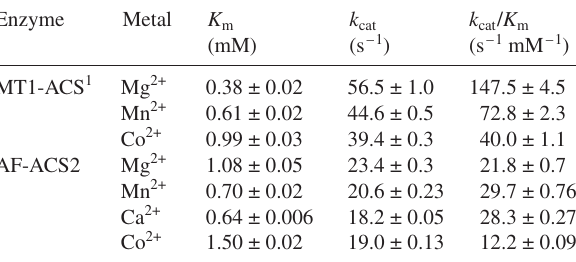
1 Kinetic parameters for MT-ACS1 were determined in the presence of 0.5 mM